Question: State the chart type depicted above.
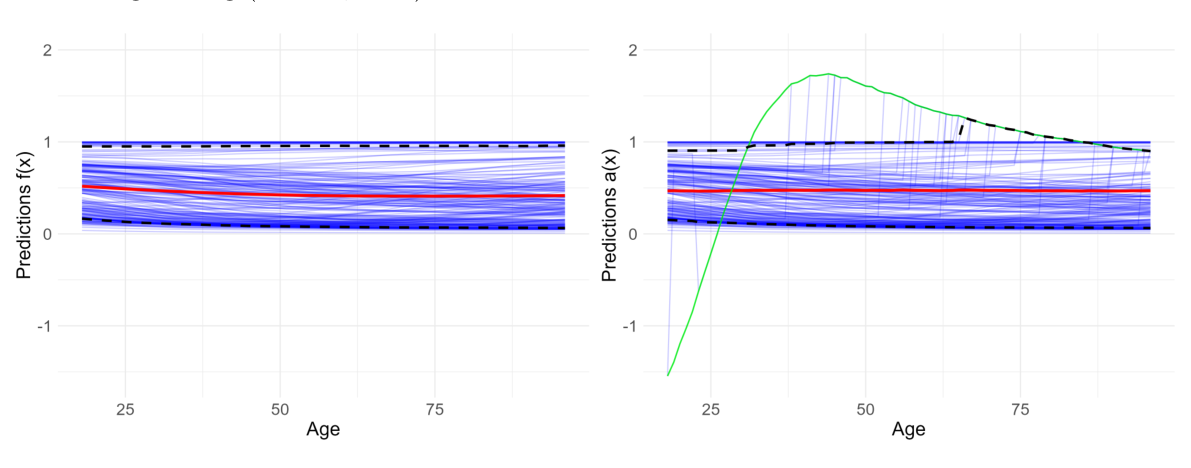
Answer: line